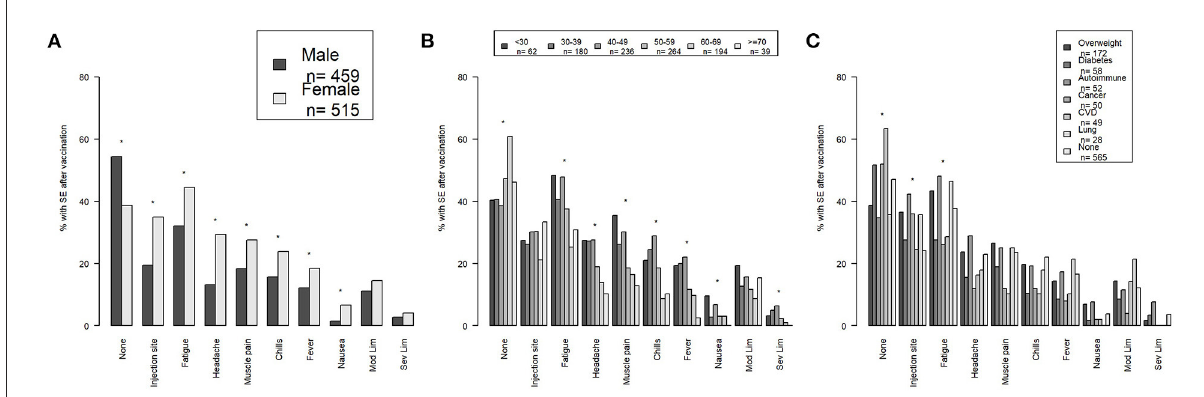
FIGURE1 The percentage of no side effects and each specific side effect including mild-moderate and severe limitations by (A) sex, (B) age group, and (C) common health conditions are shown for all vaccinated participants. Side effects after second/single dose are depicted. *Indicates a p -value < 0.05. SE, side effects; Mod Lim, mild-moderate limitations; Sev Lim, severe limitations; CVD, cardiovascular